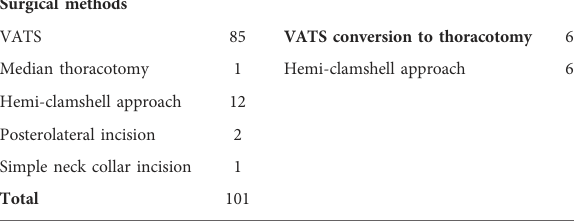
TABLE 2 Type of surgical methods in patients with mediastinal mature teratoma.